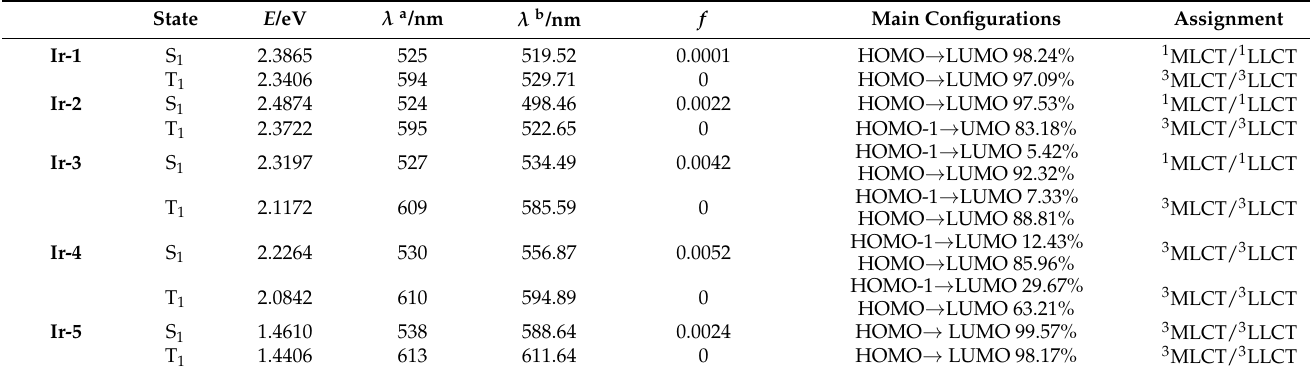
Table 3. The calculated excitation energies (eV), wavelengths (nm), oscillator strengths, dominant contributing configurations of complexes Ir-1 – Ir-5